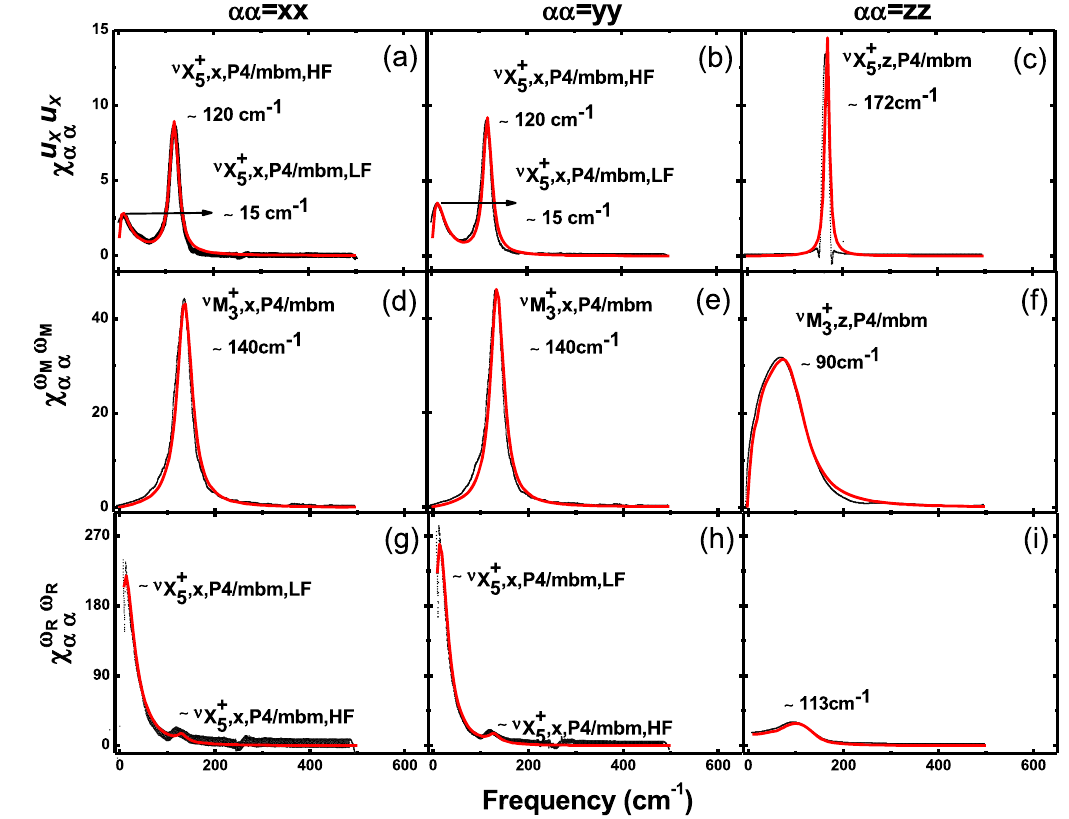
Fig. 3 Same as Fig. 2 but for a temperature of 1260 K (which corresponds to the P4/mbm